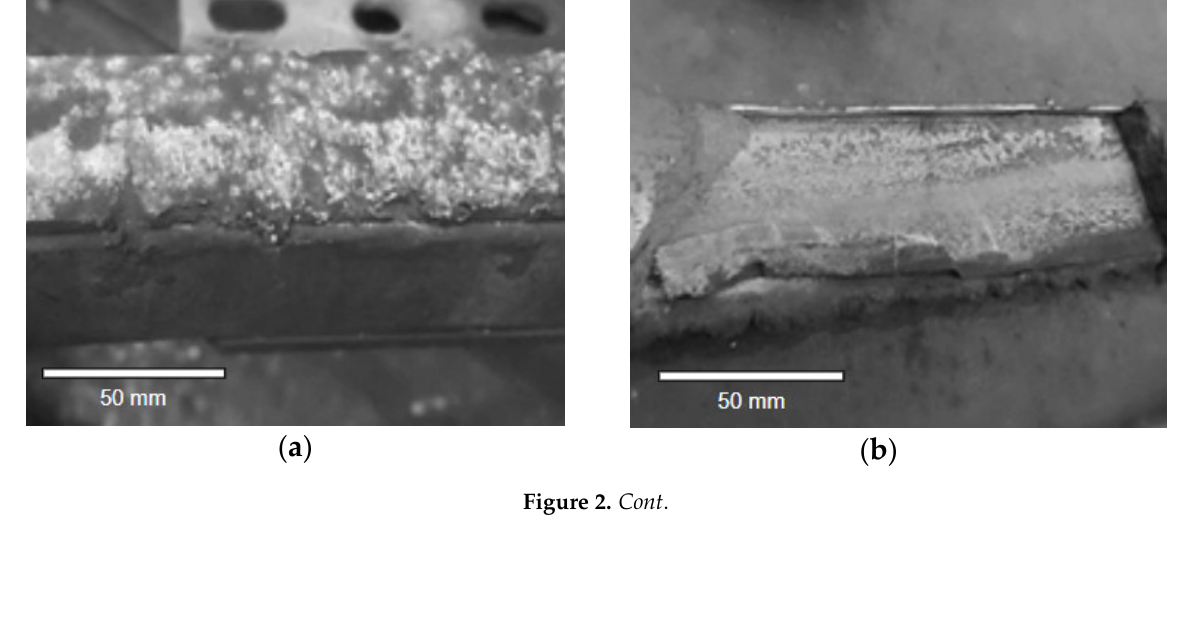
( d ) Figure 2. Wear of the sliding: ( a ) material melting as a result of arcing; ( b ) detachment of a piece of carbon strip; ( c ) crack of a strip; and ( d ) the top layer of a strip is peeling off [30]. In the case of wear, a reduction in the thickness of the strip may be noticed as a result of the abrasion processes and electro-eroding phenomena. The wear process induces an approximately monotonous change in the thickness of the sliding strip. The reason for replacing the sliding strip in this case exceeds the recommended strip thickness. If some small defects occur—which do not cause any loss of the strip’s current collection ability, e.g., by wearing the edge of the strip—there is no need to replace the strip (Figure 1a). Such damages are caused by the impact on the hard points of the catenary and it is often assumed that minor surface damages may not exceed 30% of the surface of the carbon strip. However, if there is any major damage (Figure 1b), then the strip should be replaced, because it may damage the overhead line. In the case of replacement following damage, there are steps to be undertaken fol- lowing certain evaluation criteria such as: 